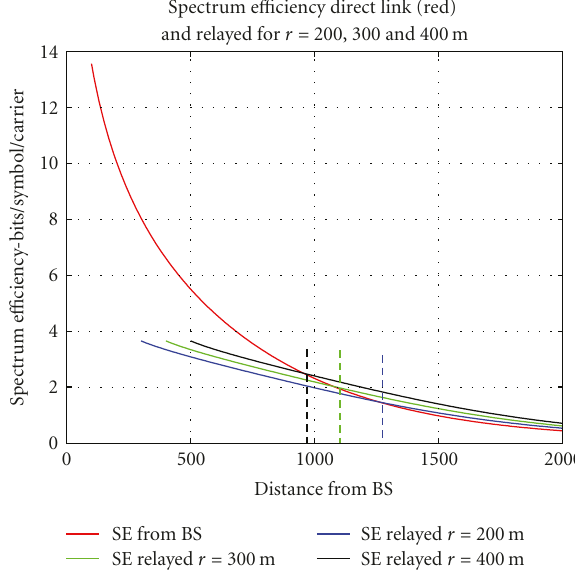
Figure 3: MS coverage radius impact to end-to-end SE for opportunistic